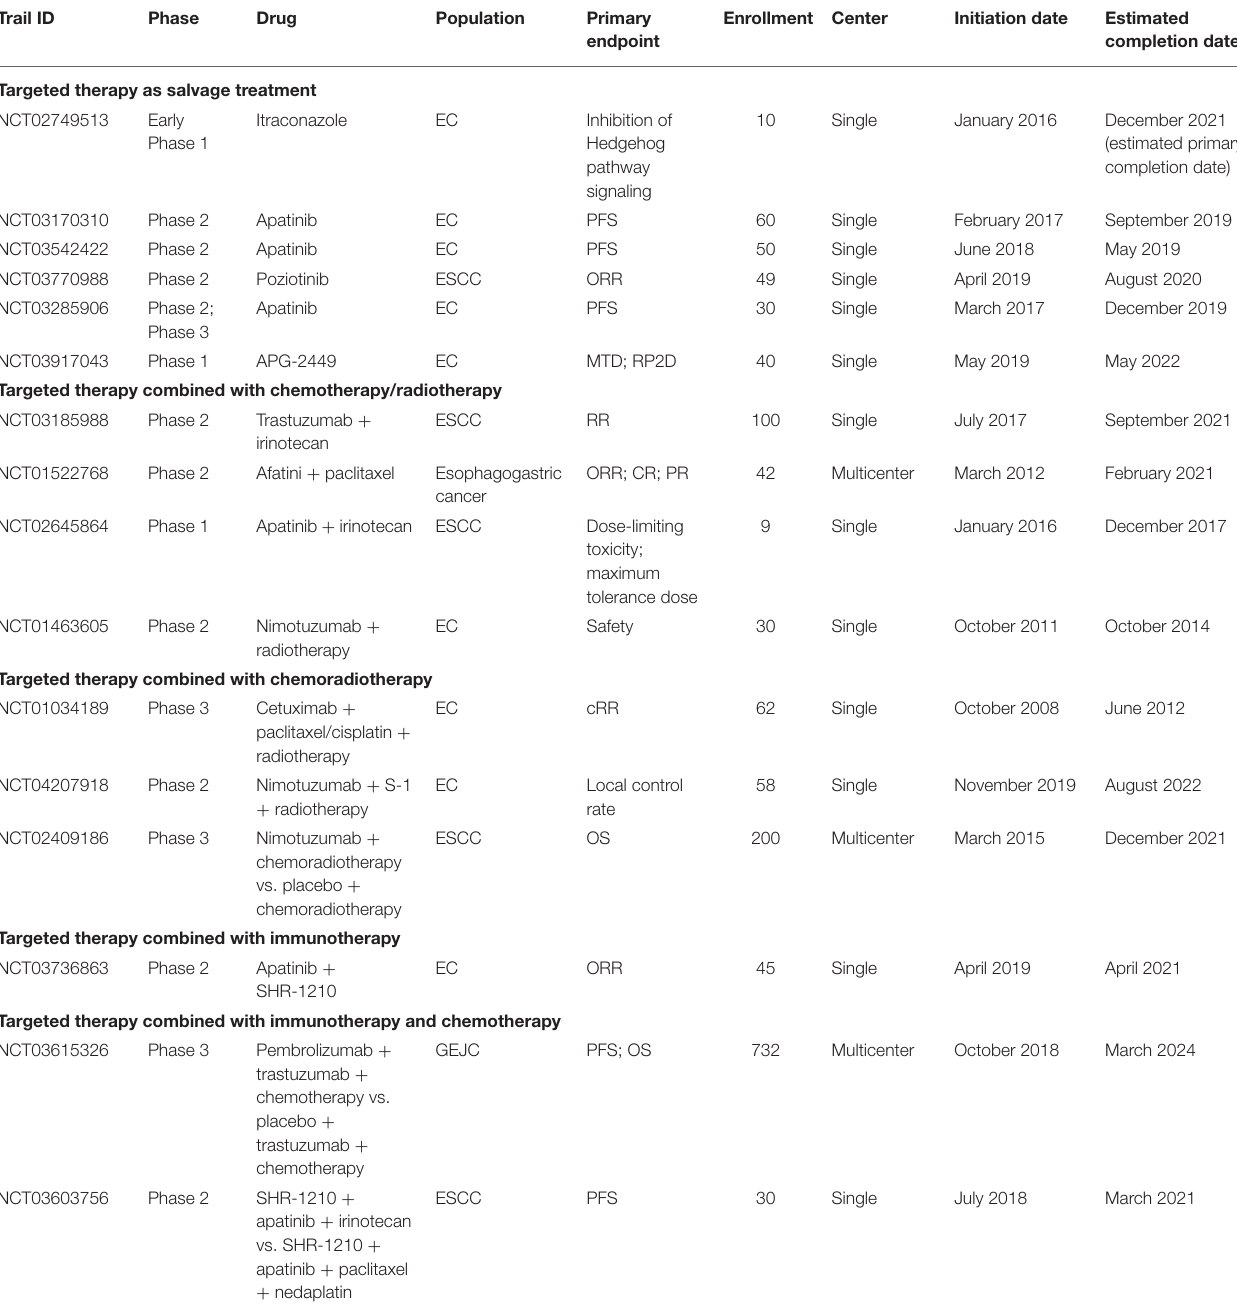
TABLE 1 | Ongoing clinical trials of targeted therapy for esophageal cancer in China. Trail